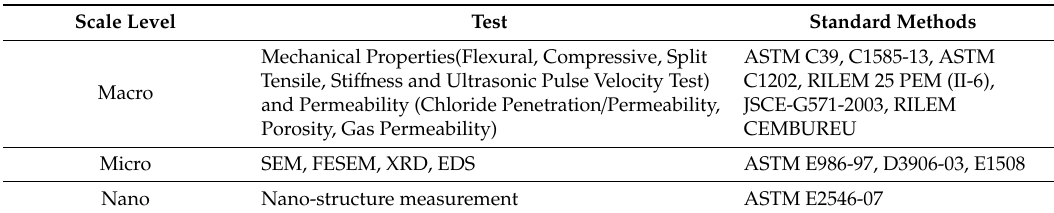
Table 1. Macro, Micro and Nano Structure Tests.